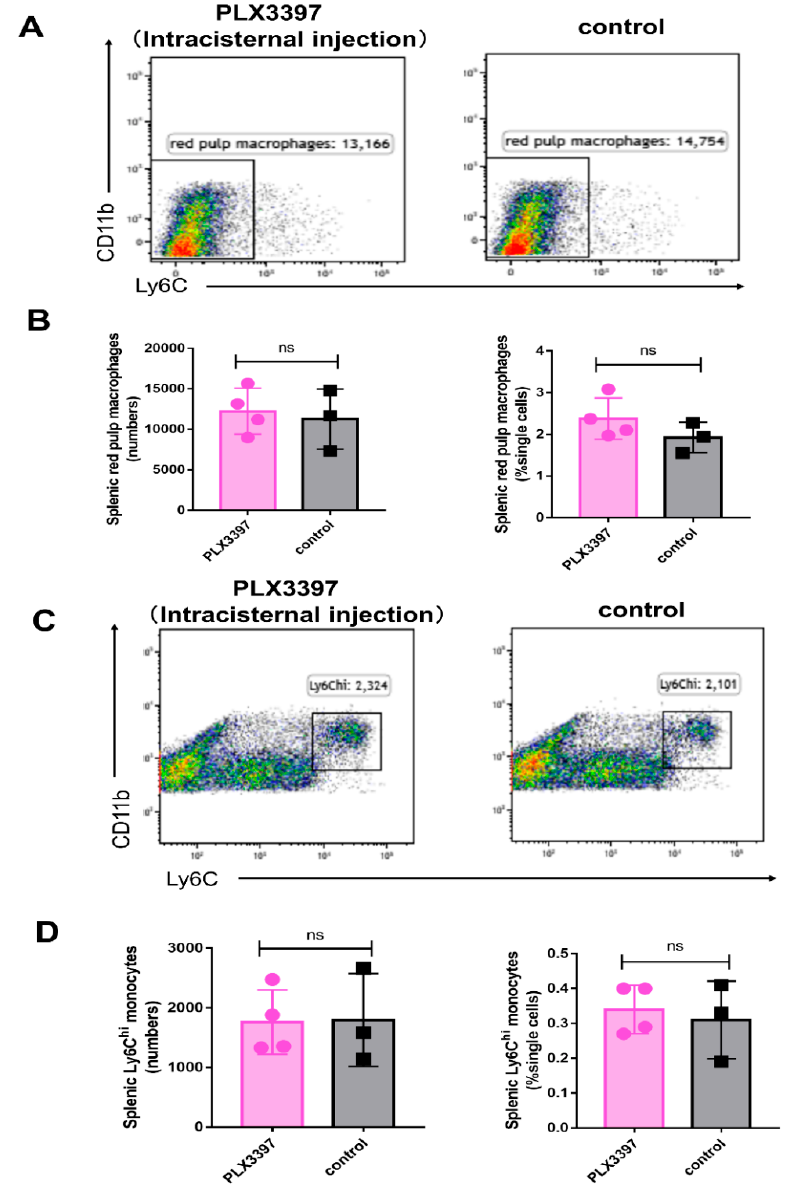
Figure 7. Intracisternal injection of PLX3397 does not exert a significant effect on splenic myeloid cells. ( A , B ) The number and percentage of red pulp macrophages ( ± SEM) in the spleen following intracisternal injection of PLX3397 (PLX3397 treatment group, pink bars; control, black bars, n = 4, 3, respectively). ( C , D ) The number and percentage of splenic Ly6C hi monocytes ( ± SEM) following intracisternal PLX3397 treatment (PLX3397 treatment group, pink bars; control, black bars, n = 4, 3, respectively). ns: not significant.